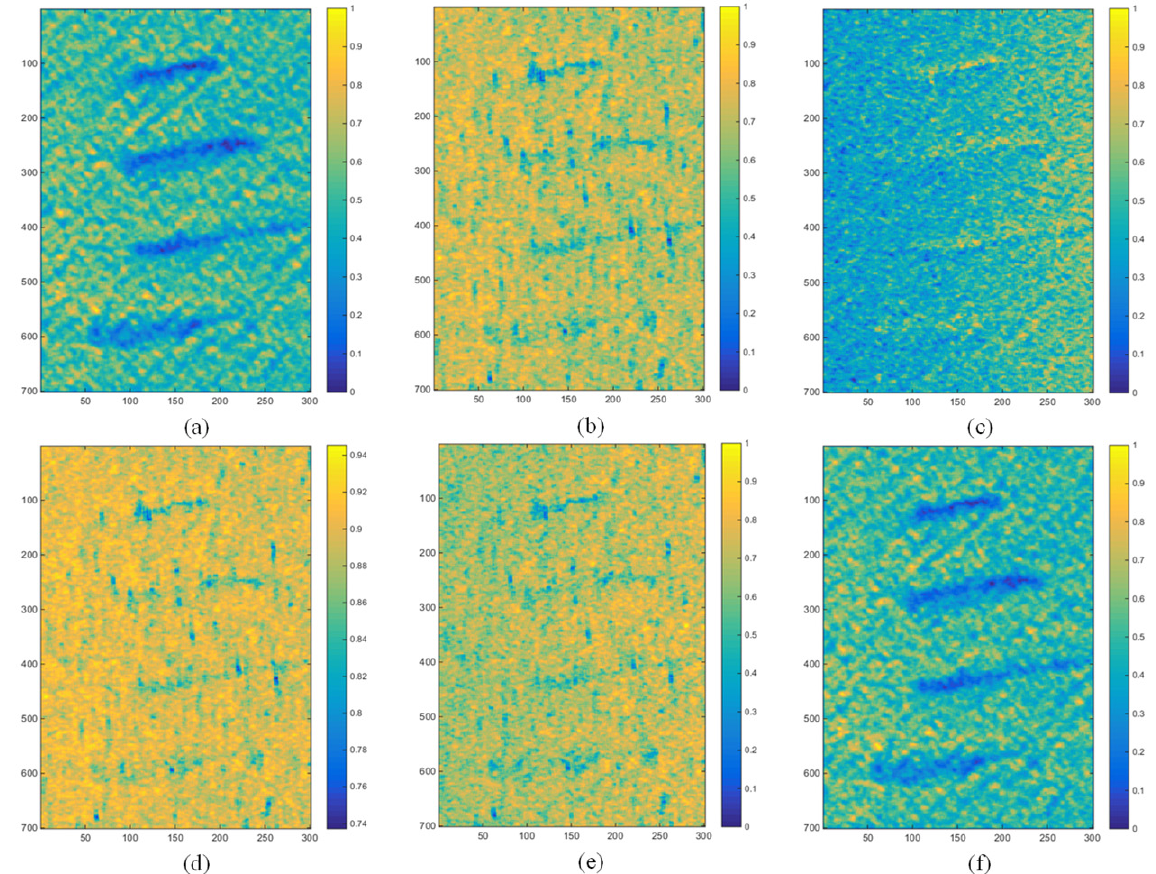
√ g 0 ; ( b ) 1 − H w ; ; ( b ) 1 − 𝐻 ; ( c ) (cid:3050) 0